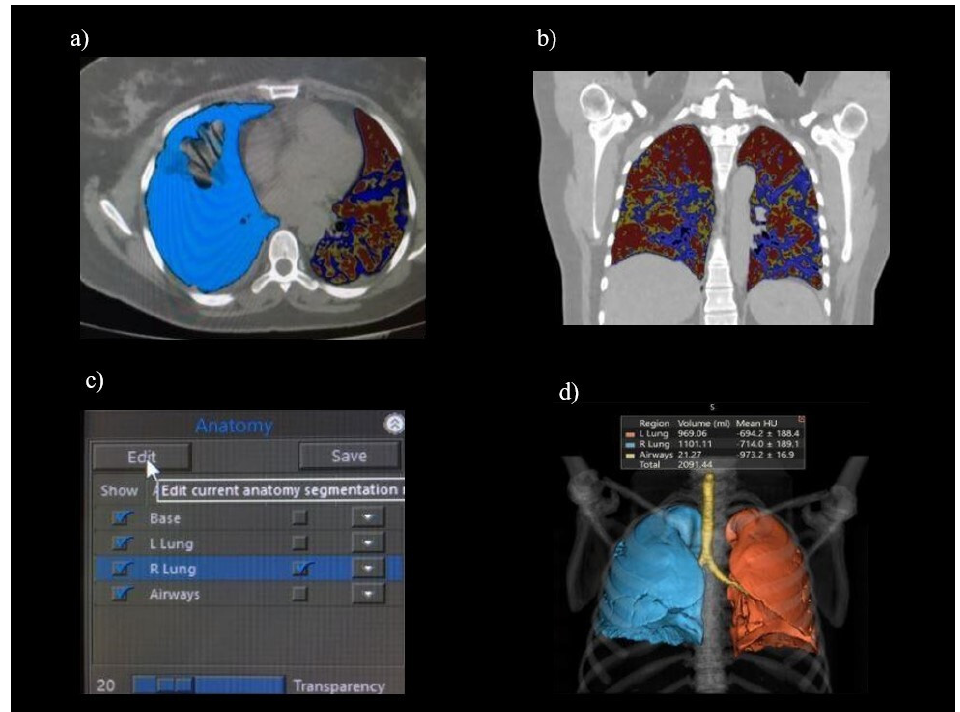
Figure 4. CT Lung Density Analysis. This image shows: ( a ) parenchyma contouring; ( b ) lesion display; ( c ) manual editing; ( d ) final result with a volumetric rendering